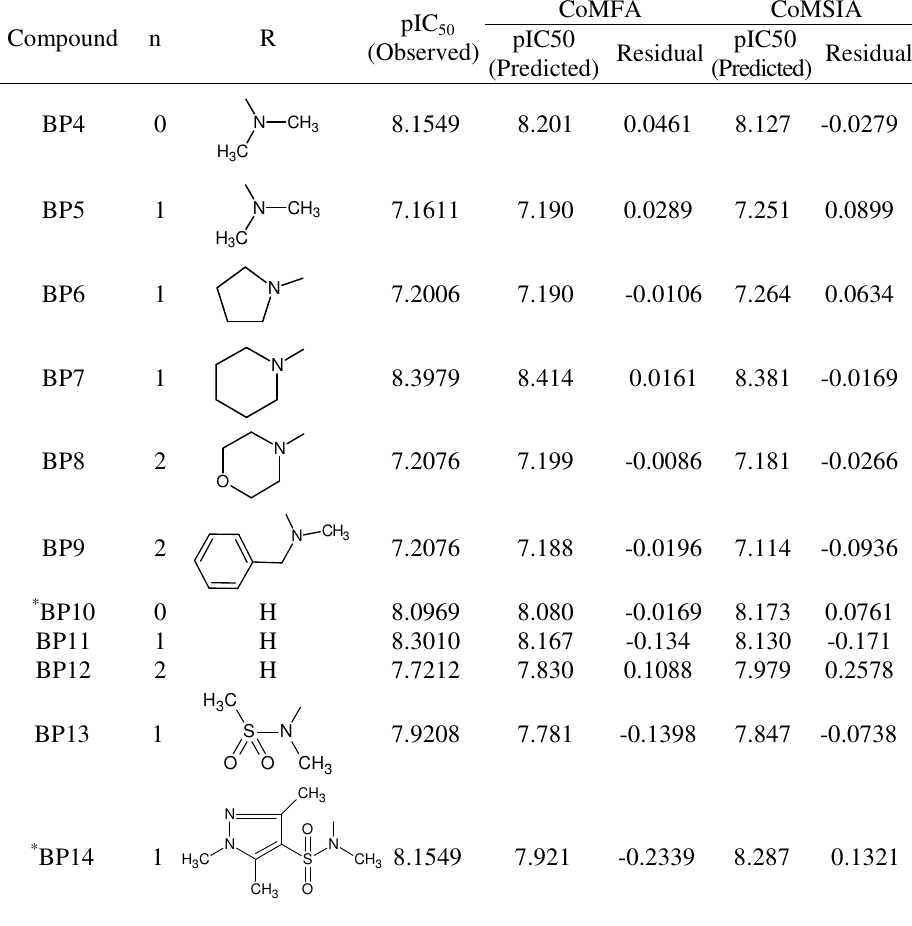
Table 1 (b). Structures and biological activities of molecules used in the present study